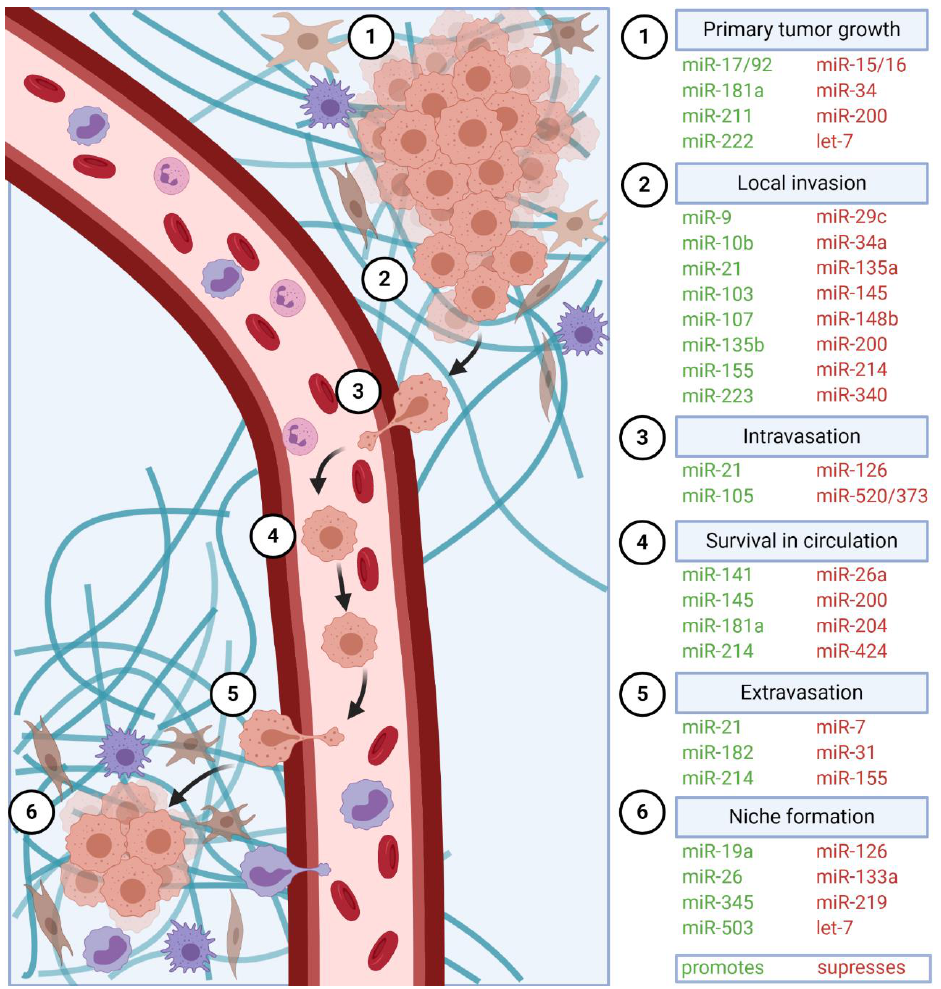
Figure 2. Regulation of cancer progression by miRNAs. Cancer progression involves several crucial steps, including ( 1 ) primary tumor growth, ( 2 ) migration and local invasion, ( 3 ) intravasation, ( 4 ) survival in the circulation, ( 5 ) extravasation, and ( 6 ) pre-metastatic niche formation (stromal cells, brown), recruitment of tumor-promoting immune cells (violet) and metastasis. Multiple miRNAs regulate each of these steps, and thus, act as either oncomiRs (promote cancer progression) or tumor suppressor miRs (suppress cancer progression).